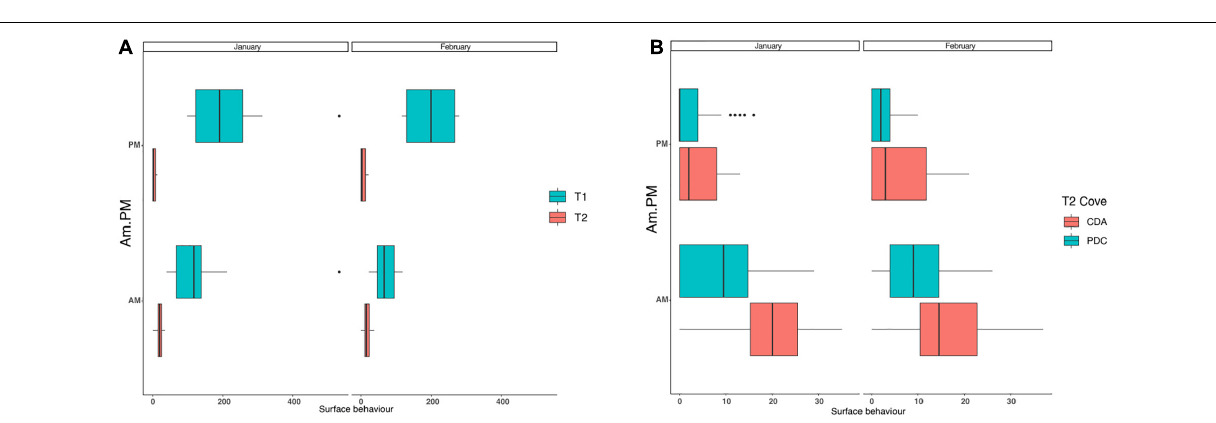
FIGURE 3 | Frequency of occurrence of the ten surface behaviors by bottlenose dolphins in the study area. Without whale watching and with whale watching for the morning (AM) and afternoon (PM) and for January and February (A) . Frequency of occurrence of the ten surface behaviors by bottlenose dolphins in the study area in T2 for the Chañaral de Aceituno (CDA) and Punta de Choros (PDC) coves, for the morning (AM) and afternoon (PM) and for January and February (B)